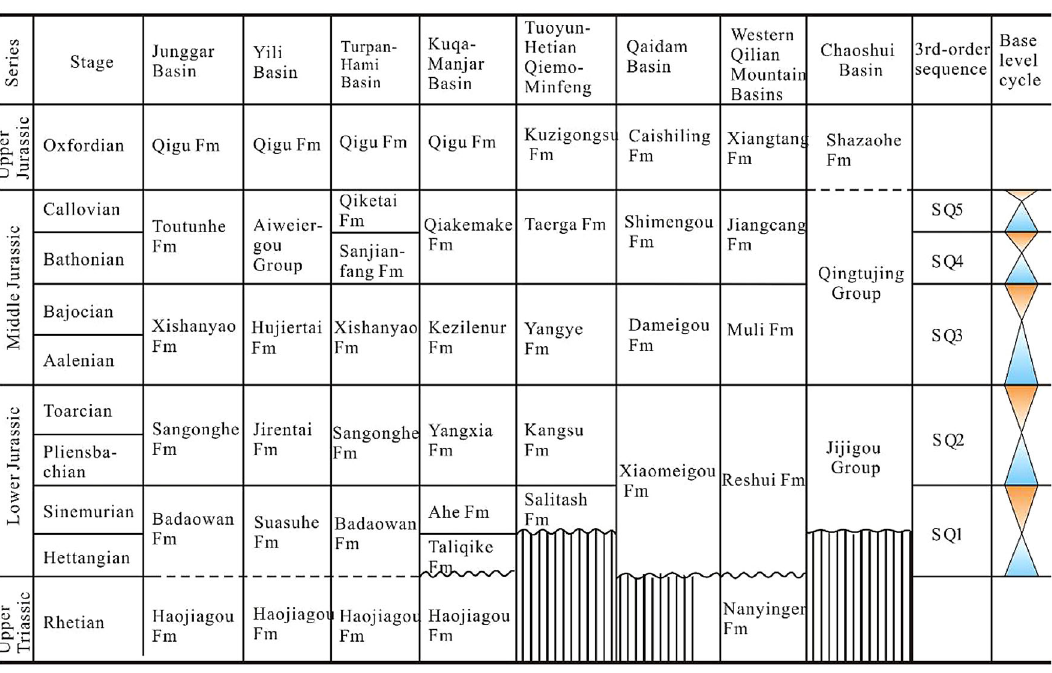
Fig. 12 Scheme of subcorrelation of the third-order sequences of the Jurassic in the Northwest China